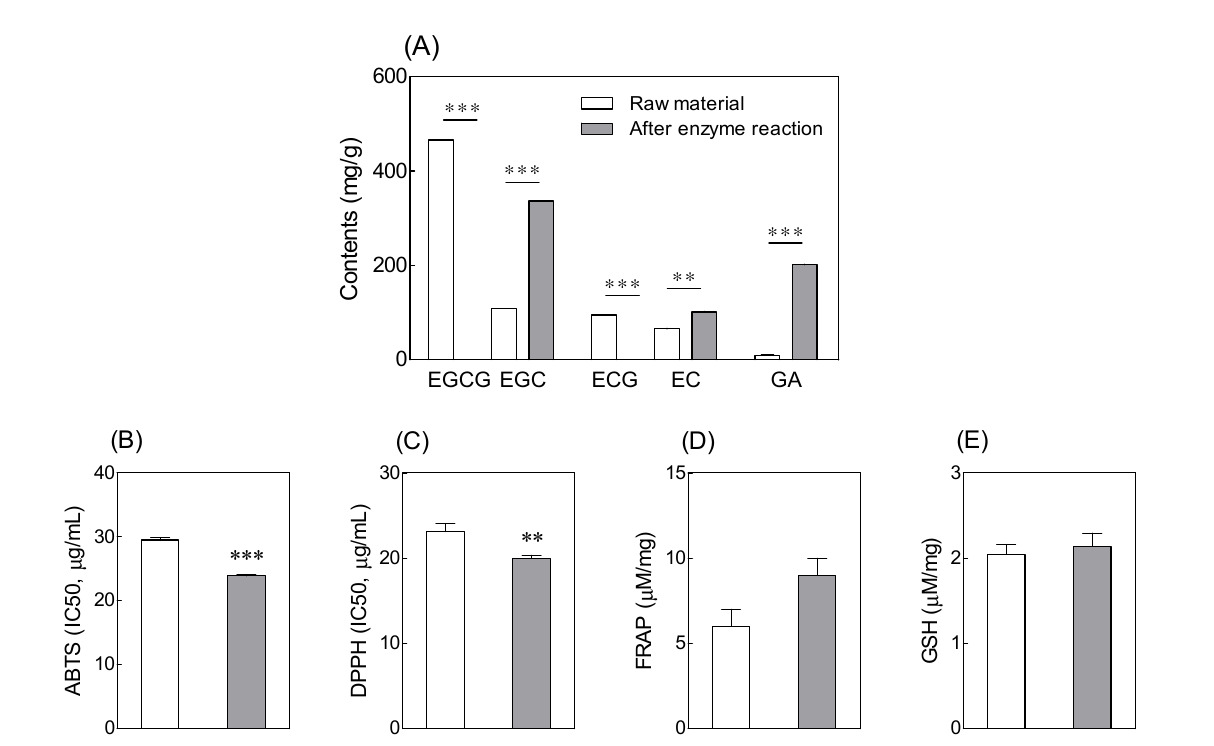
Figure 1. Effects of tannase treatment on ( A ) catechin contents, ( B ) ABTS, ( C ) DPPH, ( D ) FRAP, and ( E ) GSH contents in green tea extract. Values are represented as means ± standard deviation (SD). Different symbols indicate significant differences at p < 0.01 (**) and p < 0.001 (***) according to an independent-samples t -test. EGCG: ( − )-epigallocatechin 3-gallate; EGC: ( − )-epigallocatechin; ECG: ( − )-epicatechin 3-gallate; EC: ( − )-epicatechin; GA: gallic acid; ABTS: 2,20-azinobis (3-ethylbenzothiazoline-6-sulfonic acid) diammonium salt; DPPH: 2,2 ′ -diphenylpicrylhydrazyl; FRAP: ferric reducing/antioxidant power; GSH: glutathione. Table 1. General characteristics of the